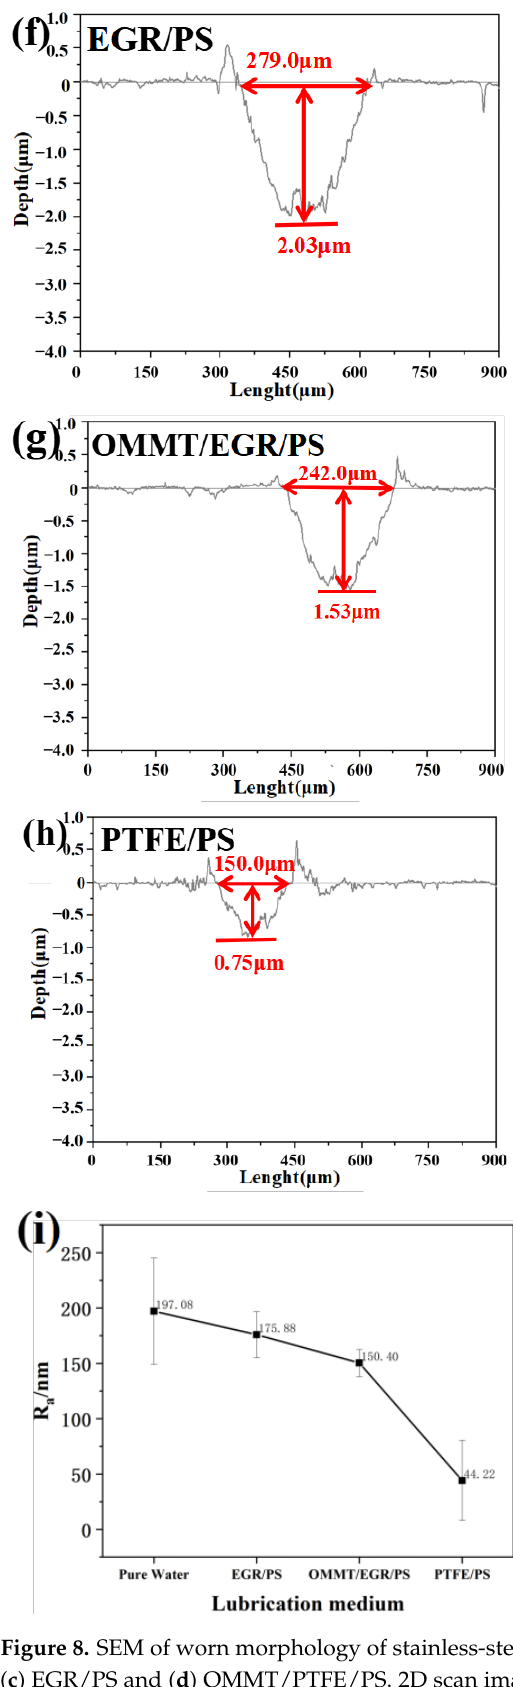
Figure 8. SEM of worn morphology of stainless-steel substrates using ( a ) pure water, ( b ) EGR/PS, ( c ) EGR/PS and ( d ) OMMT/PTFE/PS. 2D scan images of wear tracks ( e ) pure water, ( f ) EGR/PS, ( g ) OMMT/EGR/PS, ( h ) PTFE/PS, ( i ) the roughness of wear